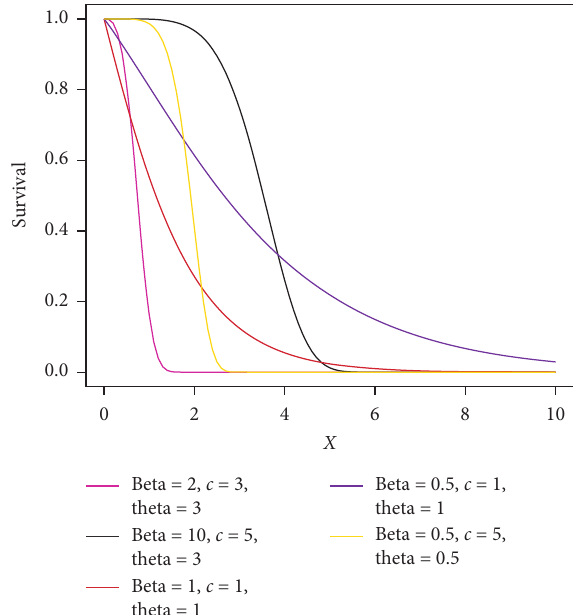
Figure 2: The cdf curves for generalized Weibull–Lindley (GWL) distribution for different parameter values.